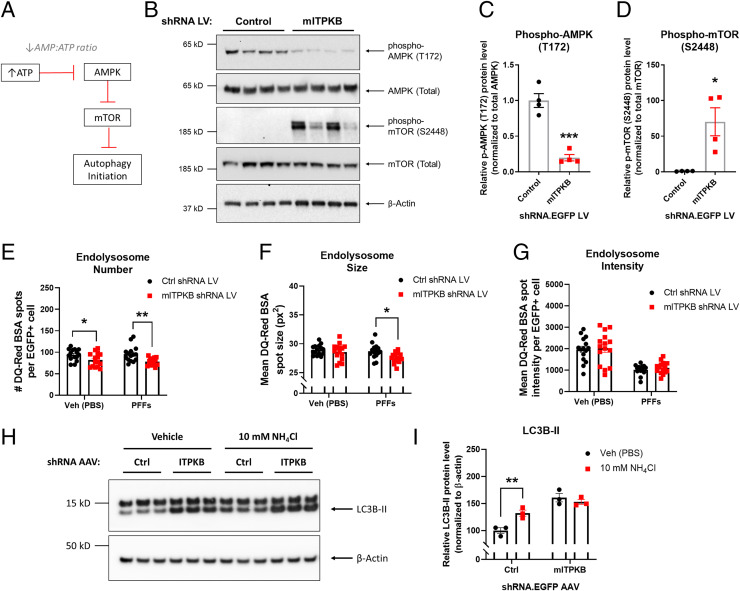
ITPKB knockdown inhibits autophagy initiation and flux via AMPK and mTOR. (A) A diagram of AMPK-mediated inhibition of mTOR under conditions of high levels of AMP relative to ATP. Note that a decrease in the AMP:ATP ratio disinhibits mTOR by reducing AMPK activity. (B) Representative immunoblots of phosphorylated (T172) and total AMPK, phosphorylated (S2448) and total mTOR, and β-Actin in DIV 20 neurons transduced with control (Ctrl) or mITPKB shRNA LV. (C, D) Quantification of levels of phospho-T172 AMPK (C) and phospho-S2448 mTOR (D) in B. ***P = 0.0003; *P = 0.0124 by unpaired Student’s t test; n = 4 wells/group. The bar graphs represent the mean ± SEM. (E–G) Quantification of the endolysosome number (E), size (F), and intensity (G) in DIV 20 neurons transduced with Ctrl shRNA LV or mITPKB shRNA LV and incubated with 4 µg/mL DQ-Red BSA for 6 h prior to live-cell imaging. The cells were treated with 2 µg/mL PFFs or vehicle (Veh [PBS]) for 11 d. *P < 0.05; **P = 0.0033 by two-way ANOVA with Sidak’s post hoc test; n = 15 wells/group. (H) A representative immunoblot of LC3B and β-Actin in Ctrl or mITPKB shRNA AAV–transduced neurons (DIV 14) treated with 10 mM NH4Cl for 6 h to induce autophagy. (I) Quantification of relative LC3B-II levels normalized to Ctrl shRNA AAV + Veh (PBS) group equal to 100 in H. **P = 0.0099 by two-way ANOVA with Sidak’s post hoc test; n = 3 wells/group. All experiments in this figure were repeated at least twice in independent cultures of primary neurons. The bar graphs represent the mean ± SEM.